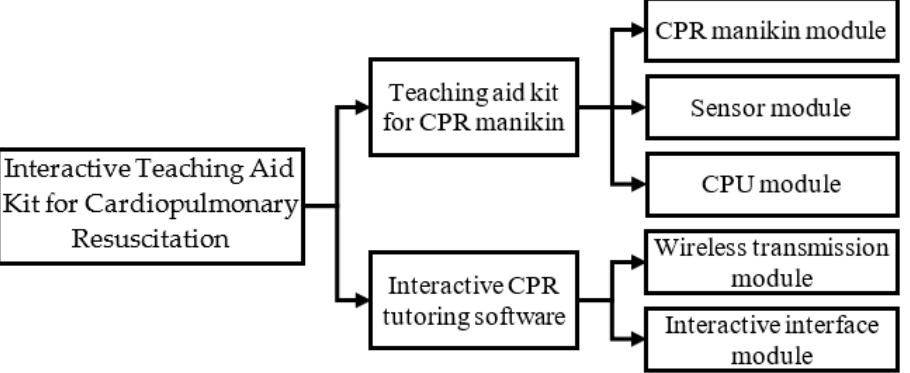
Figure 1. The framework of the teaching aid kit for CPR.